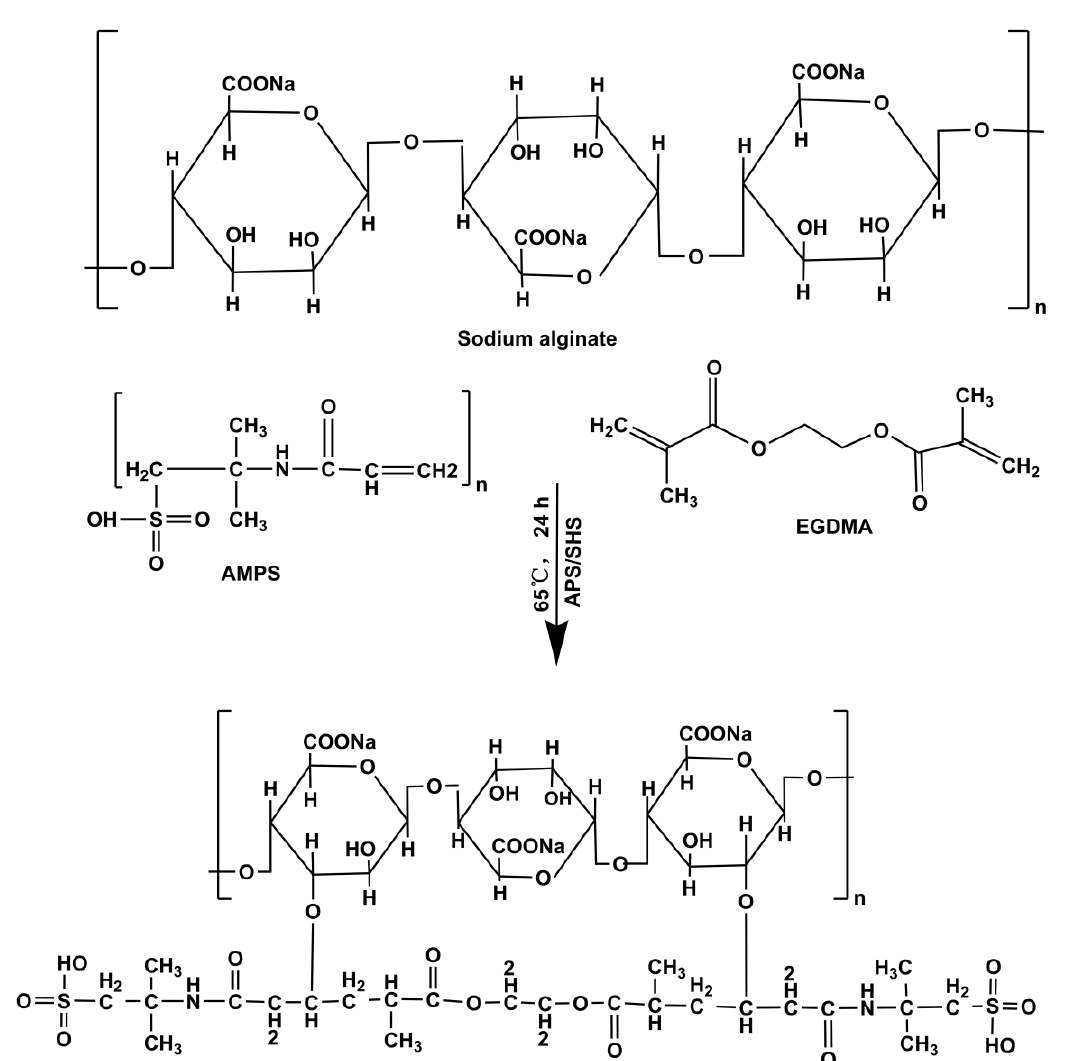
Figure 12. The proposed chemical structure of the synthesized SA- g -AMPS hydrogels.